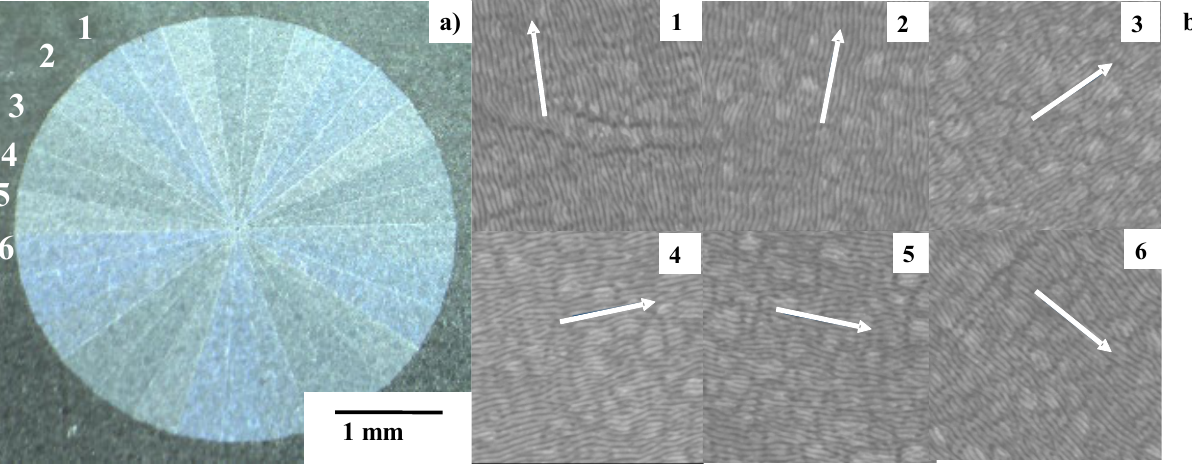
Figure 9. Micro-/nano-texturing in the femtosecond laser printing of M6 onto the nitrided flat punch. ( a ) Construction of M6 by micro-texturing in five repetitions of six segments, and ( b ) nano-texturing with controlled orientation in each segment from #1 to #6 in Figure 8a.